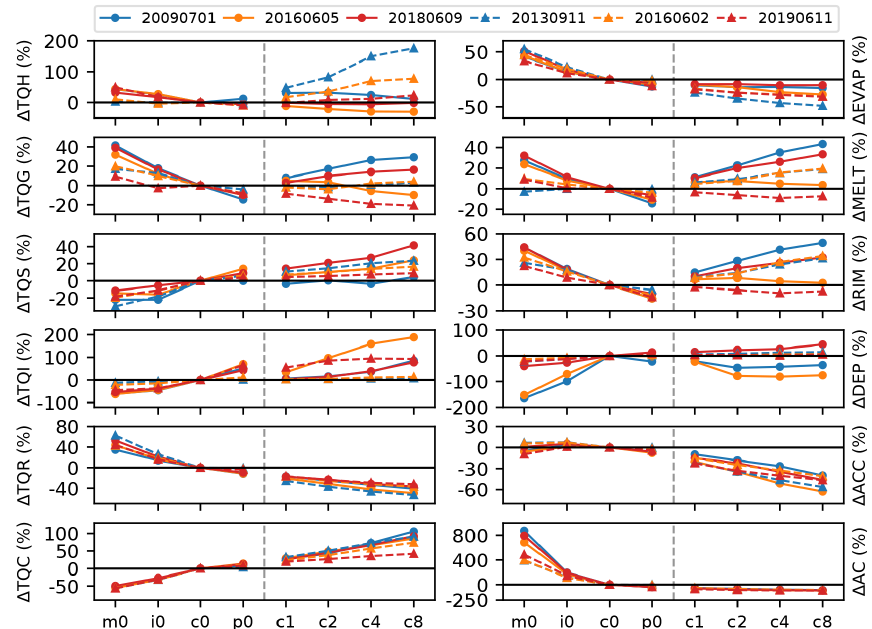
Figure 9. Spatiotemporal averages of percentage deviations from the reference run of total cloud water (TQC), rain water (TQR), ice (TQI), snow (TQS), graupel (TQG), and hail (TQH) amounts (left column) and of autoconversion (AC), accretion (ACC), deposition (DEP), riming (RIM), melting (MELT), and evaporation (EVAP; right column). Weak forcing cases have solid lines, and strong forcing cases have dashed